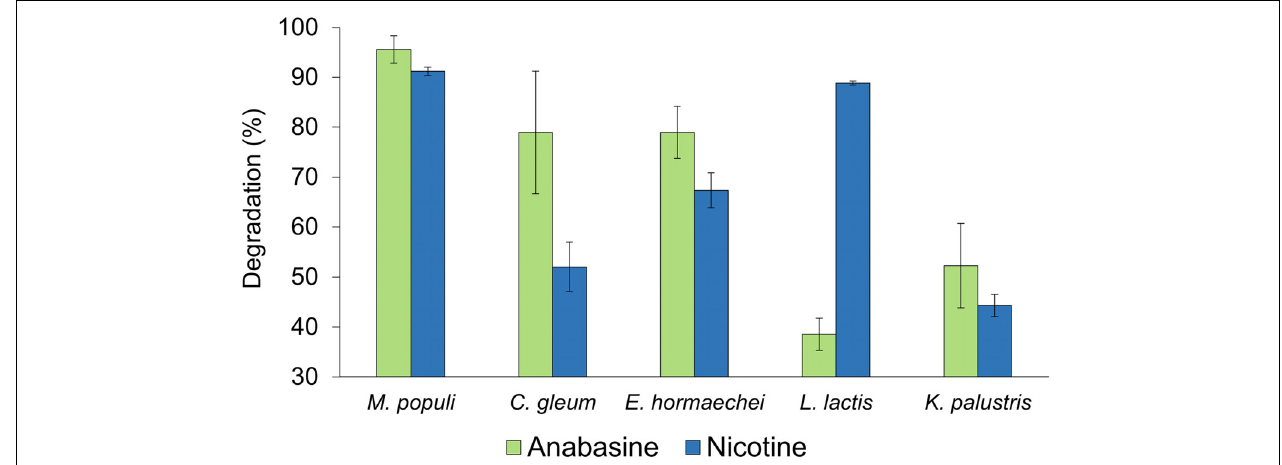
FIGURE 5 | Anabasine and nicotine degradation activities by the five sunbird bacterial isolates, Methylorubrum populi , Chryseobacter gleum , Enterobacter hormaechei , Lactococcus lactis , and Kocuria palustris . Results are presented as mean ±